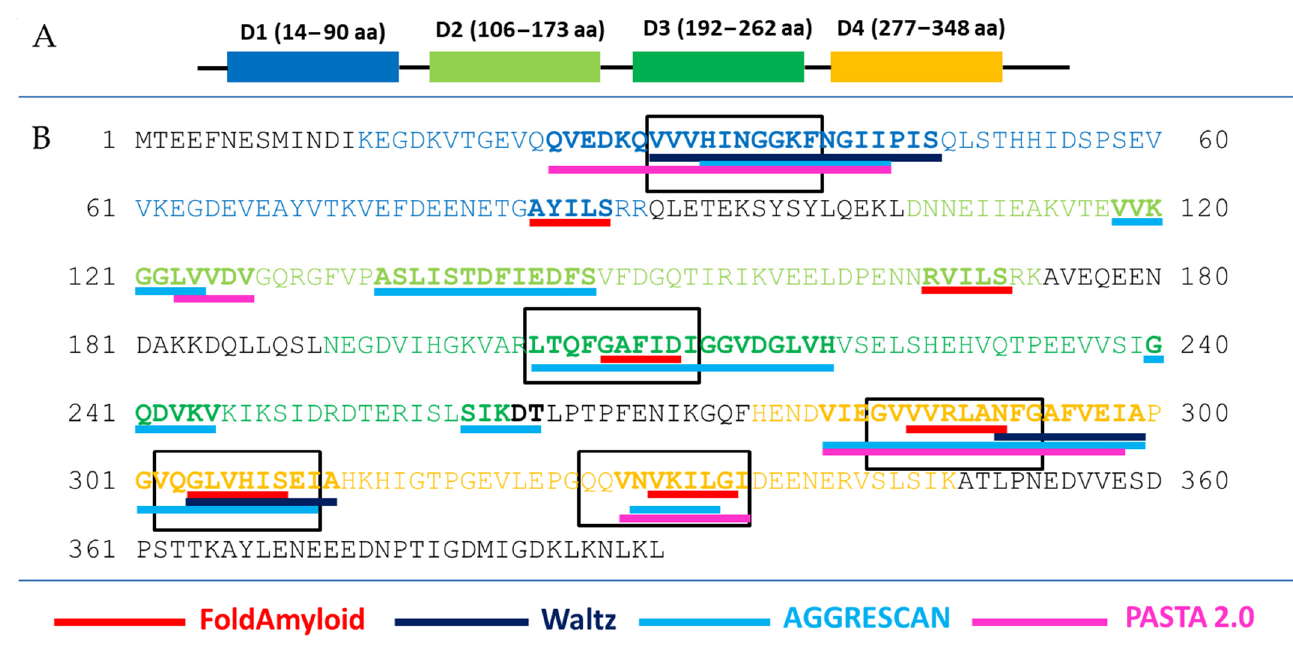
Figure 2. Schematic representation of the S1 domain organization from S. aureus ( A ) and the results of prediction of amyloidogenic regions ( B ). Amino acid sequences included in the domains are color-coded—blue (domain 1, D1), light green (domain 2, D2), dark green (domain 3, D3), orange (domain 4, D4). According to the prediction results, amyloidogenic regions are in bold and underlined in red (FoldAmyloid), dark blue (Waltz), light blue (AGGRESCAN), and pink (PASTA 2.0). Peptides synthesized according to the predictions of the FoldAmyloid, Waltz, AGGRESCAN, and PASTA 2.0 programs are highlighted with black rectangles. Predicted amino acid residues are highlighted in bold by at least one program.